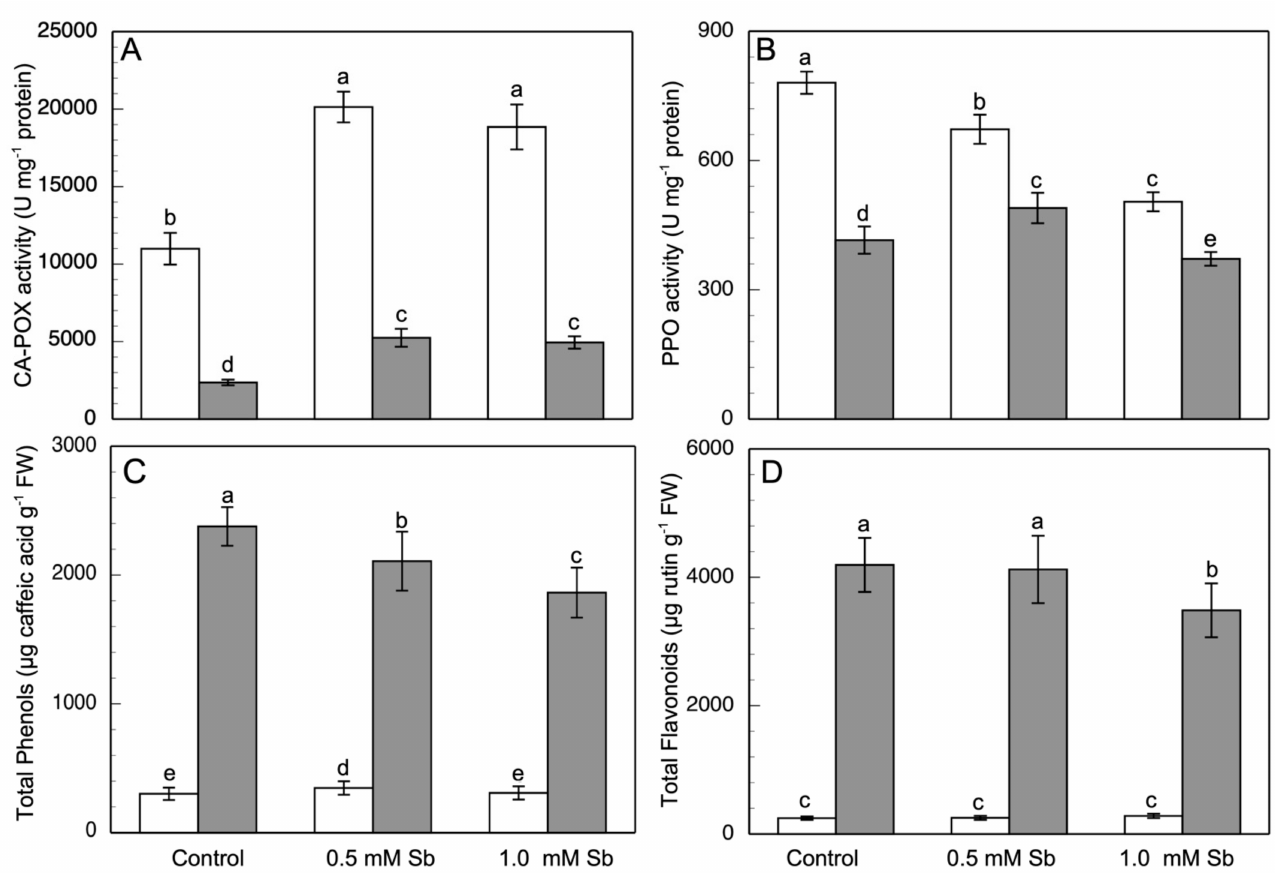
Figure 6. Effect of Sb on CA-POX ( A ) and PPO ( B ) and activities, and the total content of phenols ( C ) and flavonoids ( D ), in roots (white) and leaves (gray) of D. viscosa . The data are from 10 independent experiments, each carried out in triplicate (different letters indicate significant differences at p < 0.05, Mann–Whitney